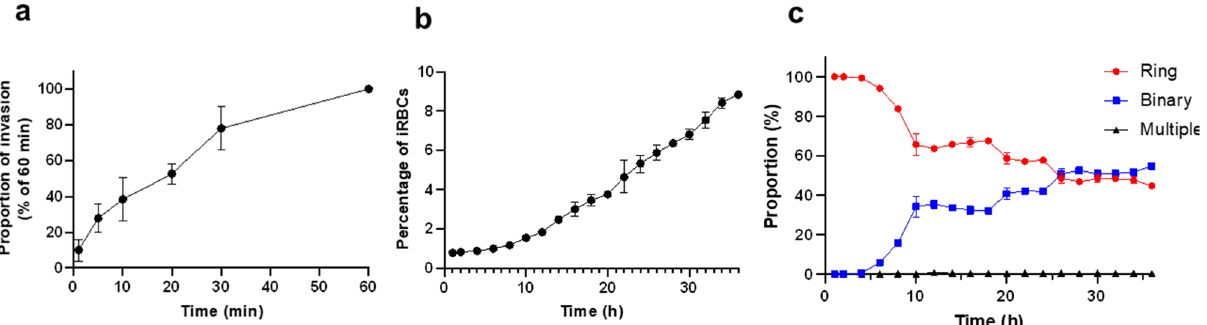
Figure 5. Invasion kinetics of B. bovis filter isolated merozoites. ( a ) The proportion of merozoites that successfully invaded erythrocytes is plotted over time relative to a 60-min maximum incubation (mean ± S.D. of three independent experiments in triplicate culture). ( b ) Parasite growth over 36 h time course. Smears were prepared every 2 h and data are shown as mean ± S.D. of triplicate culture. ( c ) Proportion of ring, binary, and multiple stages following invasion (mean ± S.D. of the triplicate experiment).